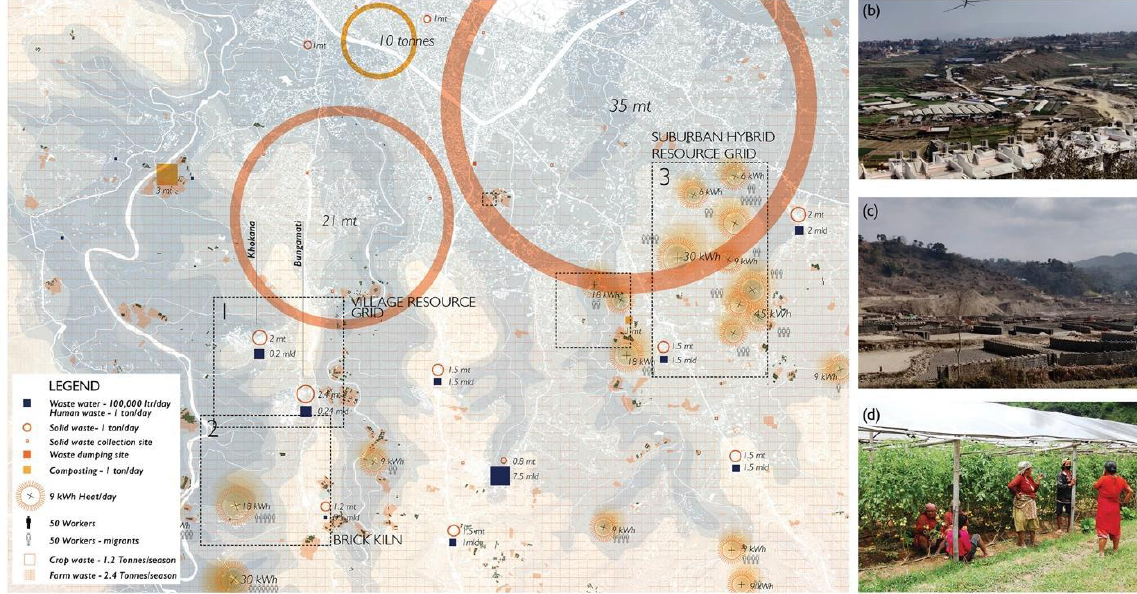
Figure 4. Wasted potentials within the landscape; (a) Map highlighting the capacities of crop residues, waste from farms, and waste produced by human activities and brick kilns, combined with market-transport, and workforce; (b) Occupation of the productive land for housing plots and commercial farming; (c) Soil extraction, removal of topsoil, disruption of irrigation and topography, reduction of farm yield; (d) Commercial- scale vegetable farming, seasonal migrant families come due to lack of employment and low turnover from agriculture. Source: